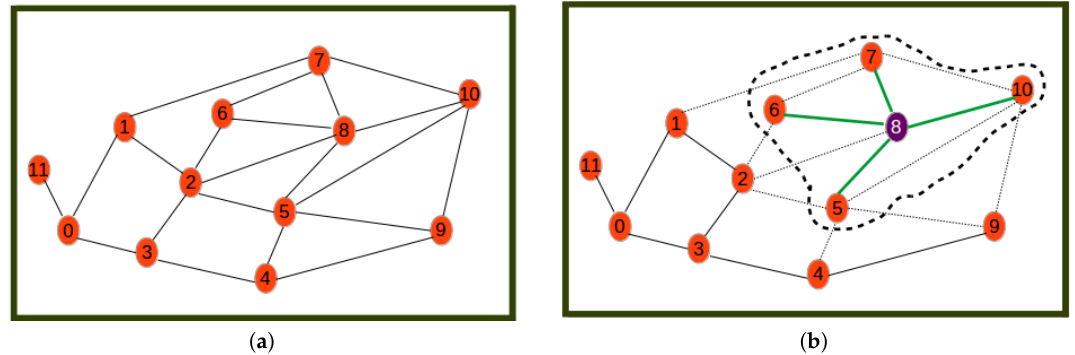
Figure 4. Beginning steps. ( a ) Step 0: initial network; ( b ) Step 1.